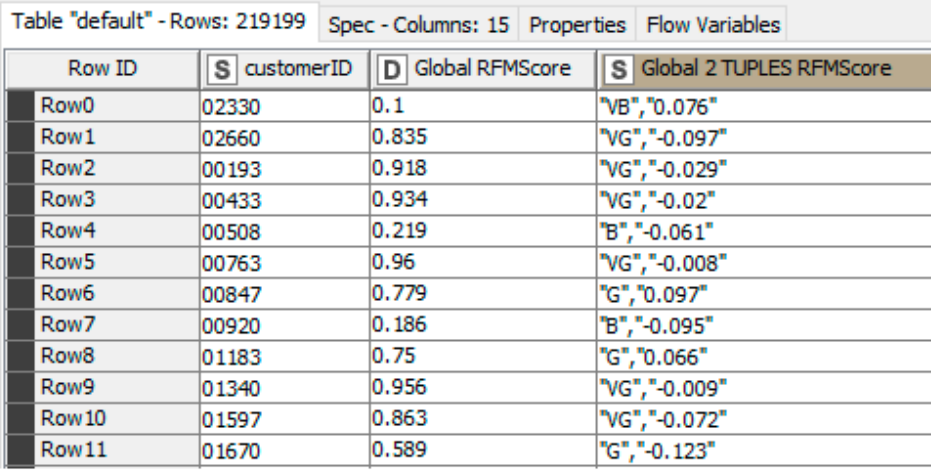
Figure 16. Output table from Knime. Sample of customers with global RFMScore and global fuzzy linguistic 2-tuple RFMScore.